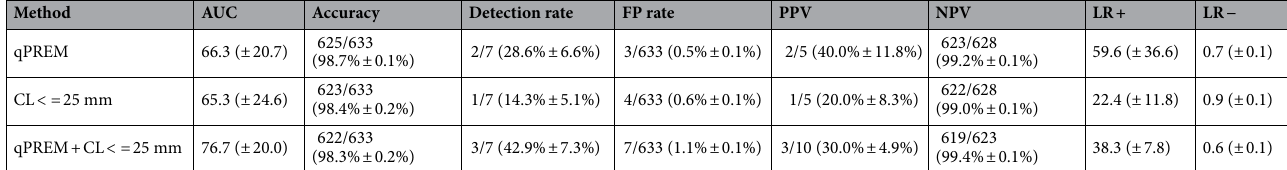
Table 3. Results for sPTB < 34. N = 633, 7 cases, 626 controls (prevalence 1.1%). qPREM QUANTUSPREMATURITY, CL cervical length, FP Rate false positive rate, PPV positive predictive value, NPV negative predictive value, LR + positive likelihood ratio, LR − negative likelihood